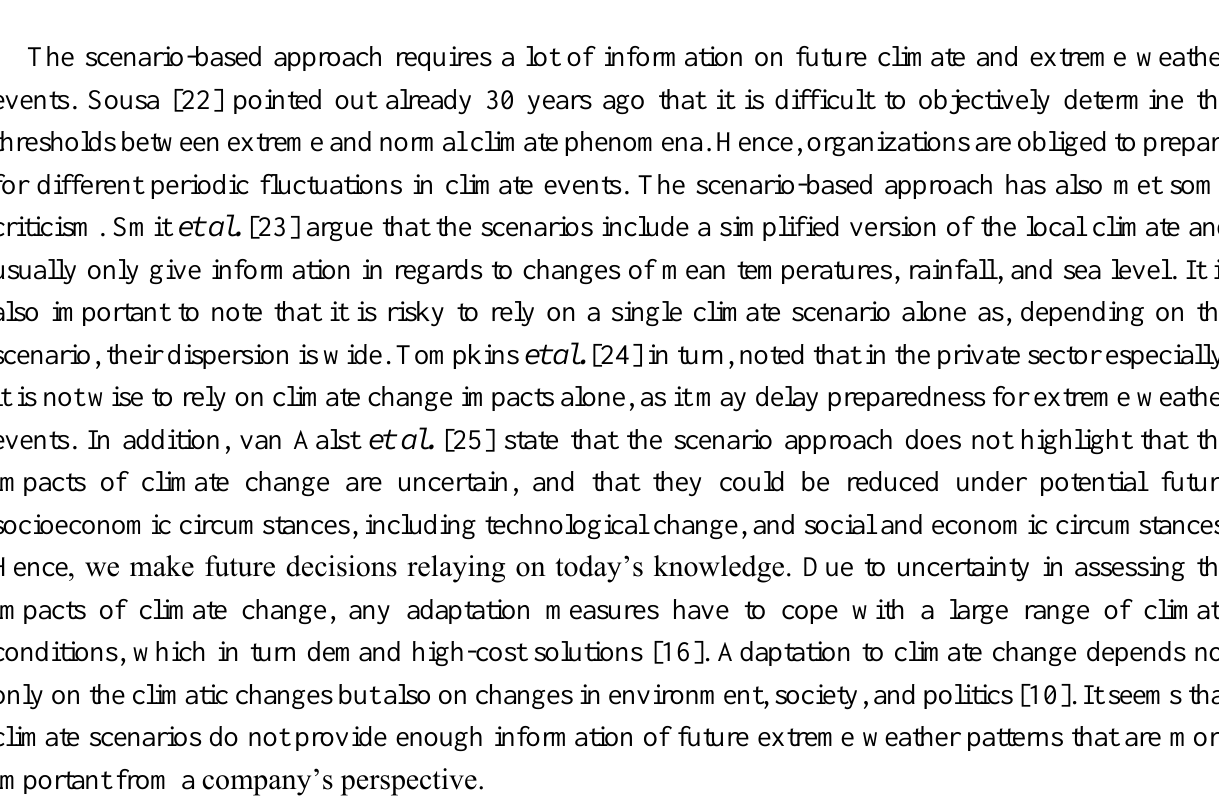
Figure 1. The suitability of risk-analysis-based and scenario-based approaches for analyzing climate change adaptation based on the planning